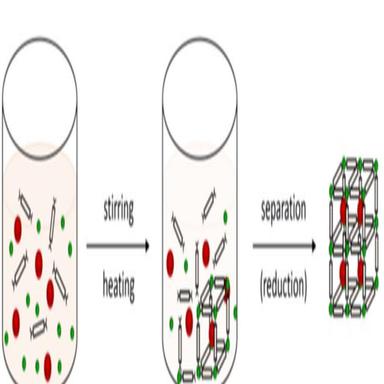
SEM images of AuCl4 @ZIF-8 with Au/Zn molar ratios of (a) 0:1, (b) 0.01:1, (c) 0.1: 1, and (d) 0.2:1. Reprinted with permission from Ref..